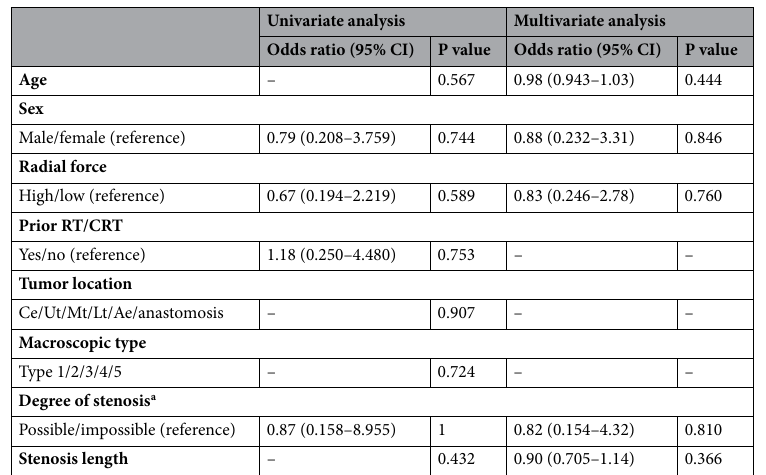
Table 4. Clinical factors associated with re-obstruction. Quantitative data was compared using Mann– Whitney’s U test. Univariate analysis was compared using Fisher’s exact test. Multivariate analysis was performed using logistic regression. Ae, abdominal esophagus; Ce, cervical esophagus; Lt, lower thoracic esophagus; Mt, middle thoracic esophagus; Ut, upper thoracic esophagus. a Stenosis was evaluated by passing an approximately 6 mm diameter nasal endoscope.